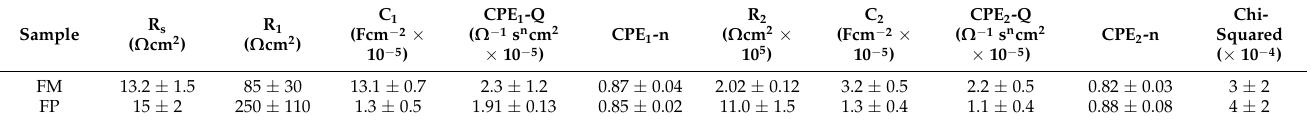
Figure 5. Equivalent circuit proposed for modelling the EIS electrochemical response of dual- phase microstructures. Table 3. The fitting values of the equivalent circuit components for FM and FP microstructures.